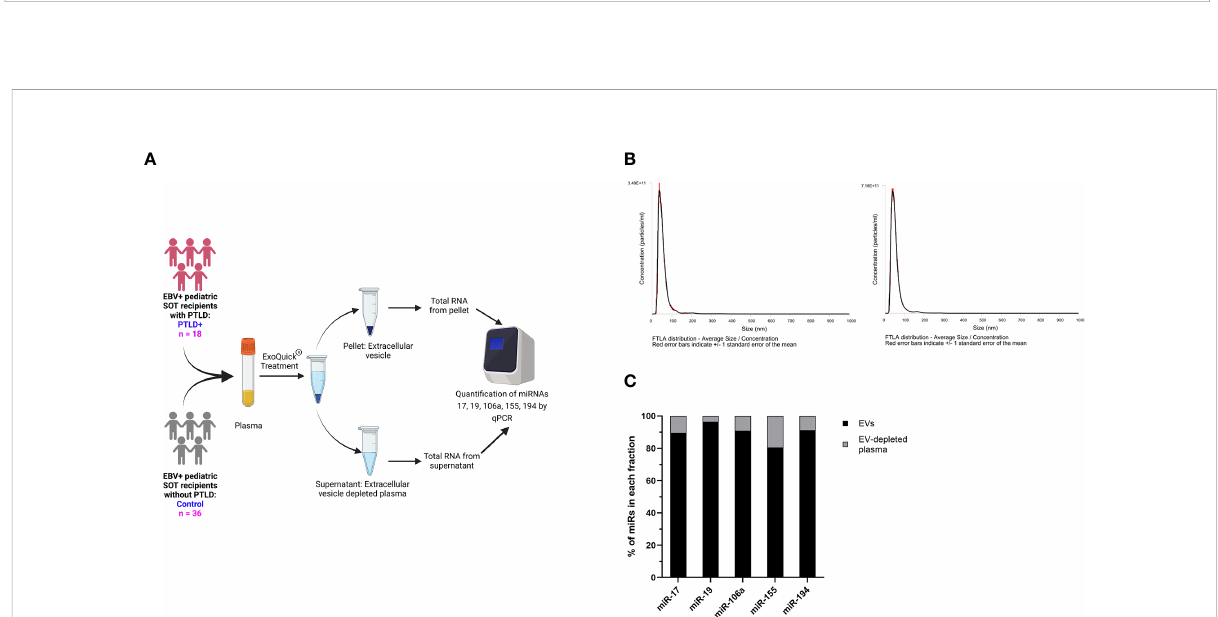
FIGURE 3 miRs are localized to EVs in plasma. (A) Schematic diagram of the work fl ow for the isolation of EVs from plasma and qPCR analysis of EV- derived miRNA from PTLD (n = 18) and control (n = 36) pediatric SOT recipients (B) Characterization of vesicles size and concentration of EVs in EV pellets isolated from plasma fraction by nanoparticle tracking analysis. (C) Concentrations of miR-17, miR-19, miR-106a, miR-155 and miR- 194 were measured by qPCR in EVs and EV-depleted plasma samples. Black bars represent the fraction of EV-derived miRNAs in whole plasma. Gray bars represent the fraction of miRNAs derived from EV-depleted